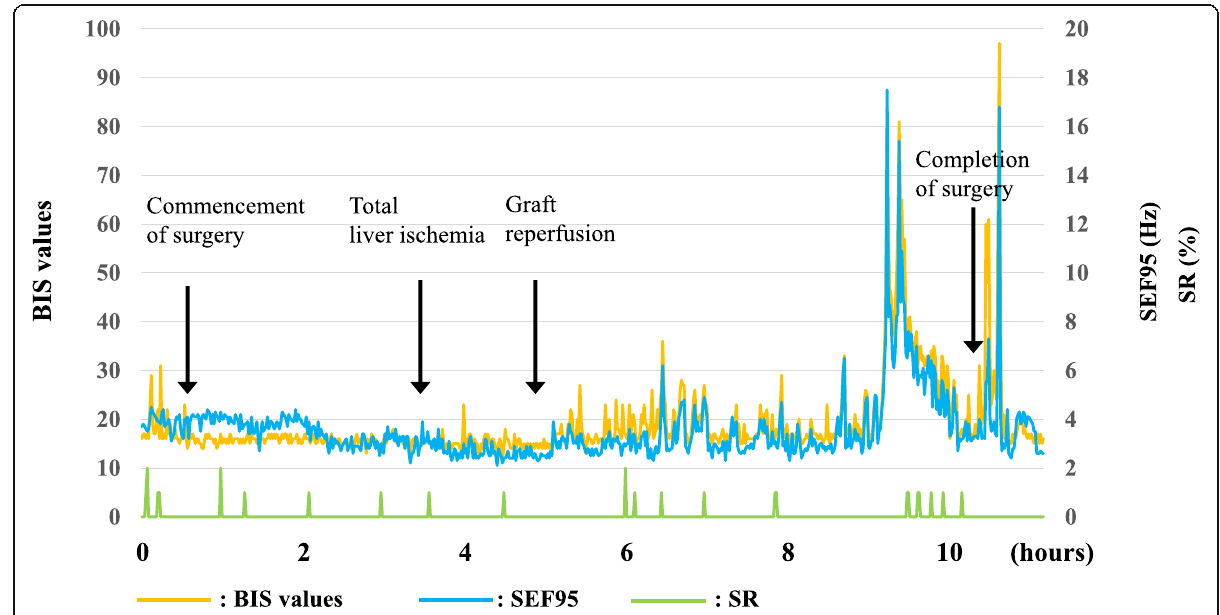
Fig. 2 Trends in BIS values, SEF95, and SR during liver transplantation. Time 0 indicates anesthesia induction. The orange, blue, and green lines represent BIS values, SEF95, and SR, respectively. The graph of BIS values and SEF95 showed almost the same changes. BIS values ranged from 10 to 20 and 10 to 80 before and after reperfusion, respectively. SEF95 ranged from 2 to 4 Hz and 3 to 17 Hz before and after reperfusion, respectively. SR was 0 – 2% before and after